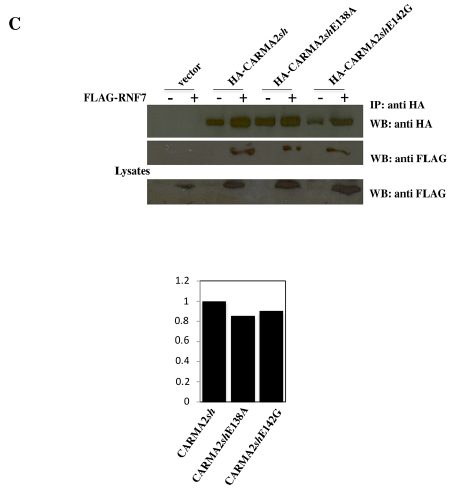
Figure 2. RNF7 represses the NF- κ B-inducing activity of CARMA2 sh . ( A ) HEK293T cells were transiently cotransfected with expression vectors encoding for CARMA2 sh (1 μ g) and RNF7 in the indicated amount, together with NF- κ B-luciferase and β -galactosidase reporter vectors. Twenty-four hours after transfection, cell lysates were prepared and luciferase activity was measured. Data shown represent relative luciferase activity normalized against β -galactosidase activity and are representative of at least ten independent experiments done in triplicate. Lower panel: A fraction of the cell lysate was analyzed by immunoblot assay to monitor protein expression. ( B ) HEK293T cells were transiently cotransfected as in ( A ) with expression vectors encoding for wild type (wt) or psoriasis-linked mutants of CARMA2 sh (1 μ g), with or without a vector encoding for RNF7. The total amount of transfected DNA was kept constant by adding empty vector. Twenty-four hours after transfection, cell lysates were prepared and luciferase activity was measured. Data shown represent relative luciferase activity normalized against β -galactosidase activity and are representative of at least 10 independent experiments done in triplicate. Lower panel: A fraction of the cell lysate was analyzed by immunoblot assay to monitor protein expression. ( C ) Upper panel: HEK293T cells were cotransfected with a plasmid encoding for HA-tagged RNF7 together with a FLAG-tagged expression vector empty or encoding for wt CARMA2 sh or psoriasis-associated mutant forms of CARMA2 sh . Twenty-four hours later, lysates were immunoprecipitated with anti-FLAG antibodies and analyzed for coprecipitating HA-RNF7 by Western blot assay. Lower panel: Densitometric analysis of RNF7 associated to wt and mutant forms of CARMA2 sh . IP: Immunoprecipitation; WB: Western Blot. We have previously shown that in human keratinocytes CARMA2 sh plays a key role in the signal transduction pathway that connects pathogen-associated molecular pattern (PAMP) recognition to NF- κ B activation [4]. In fact, exposure to PAMPs activates NF- κ B following agonistic binding to pattern recognition receptors, which includes members of the toll-like receptor family expressed on human keratinocytes [27]. Interestingly, we noted that RNF7 expression is induced in HaCaT cells exposed to heat-killed bacterial ( E. coli and S. aureus ) or fungi ( C. valida ) cells or the inflammatory cytokine IL-1 β (Figure 3A).